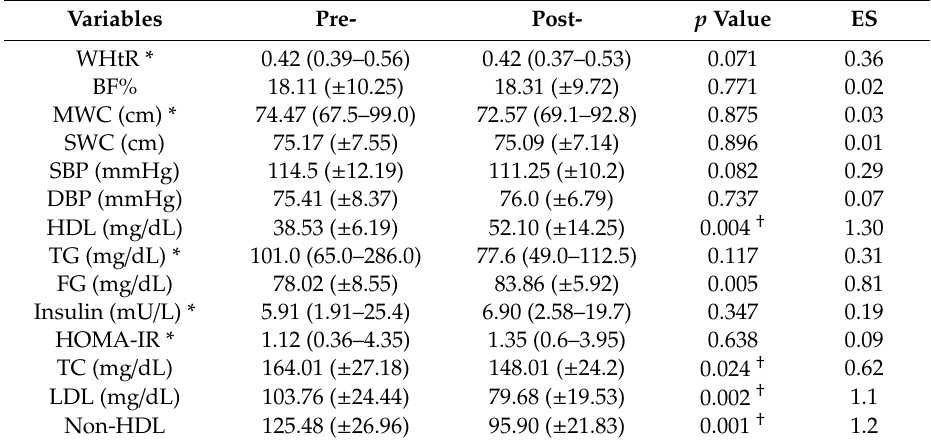
Table 4. Anthropometric and metabolic variables at pre- and post-intervention (n = 12). Variables Pre-